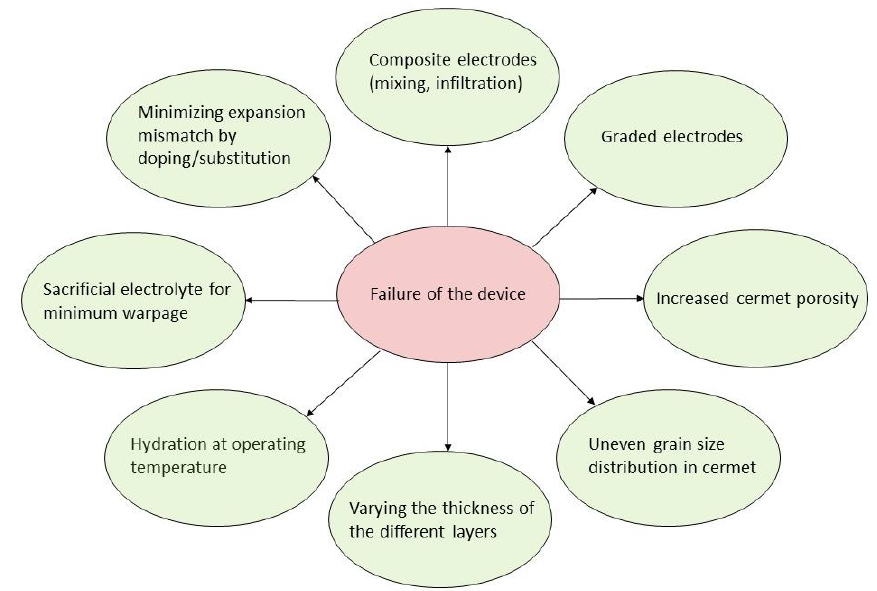
Figure 11. Summary of the different strategies when cells are failing due to mismatch between the expansion coefficients of the different layers. expansion coefficients of the different